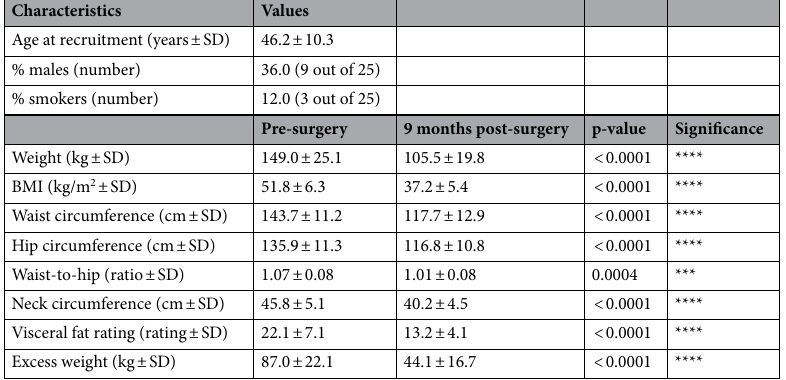
Table 1. Demographic characteristics of the studied participants (n = 25) and mean anthropometric values before and 9 months after surgery. The p-values were calculated using paired T-test. Statistical significance is indicated as: ***p ≤ 0.001 and ****p ≤